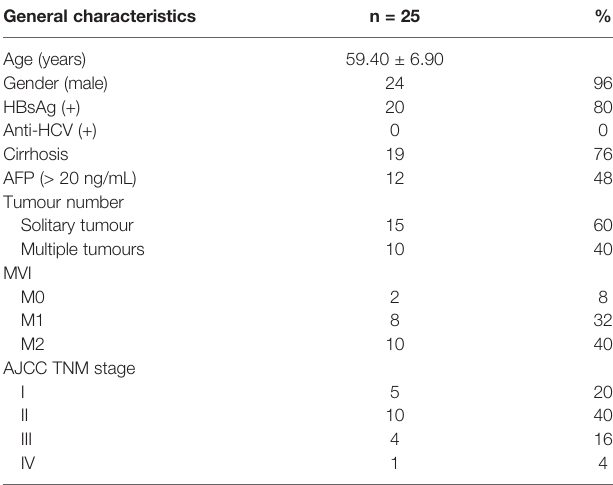
TABLE 1 | Characteristics of the included HCC